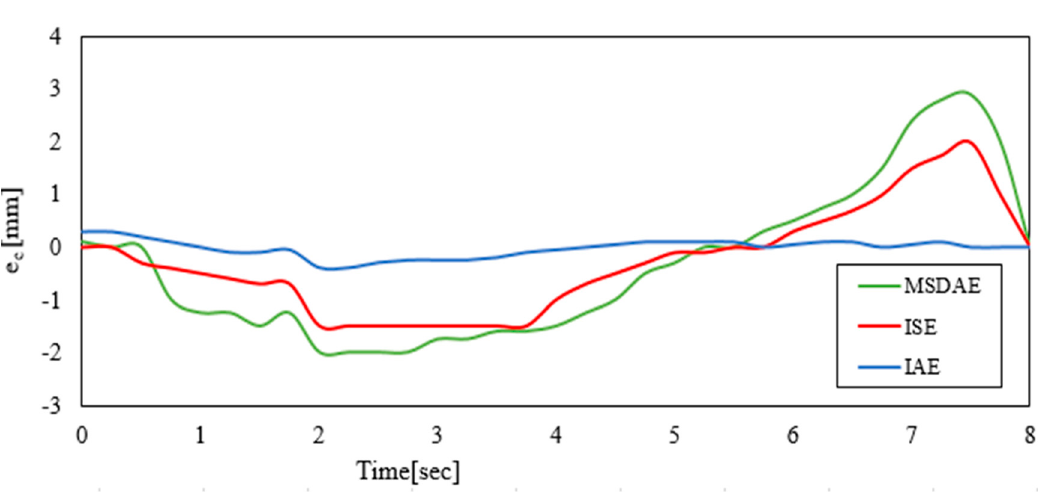
Figure 6. Contour performance of linear tracking.